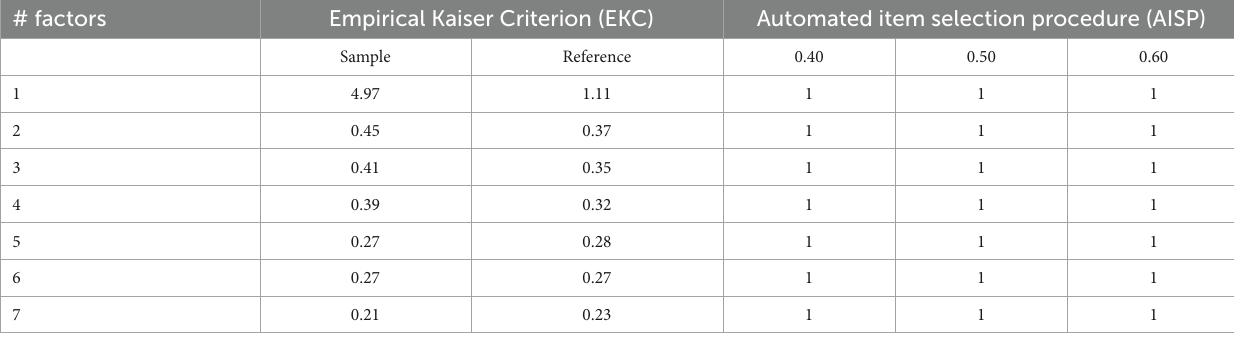
TABLE 2 Number of latent dimensions: EKC and AISP criterions. #